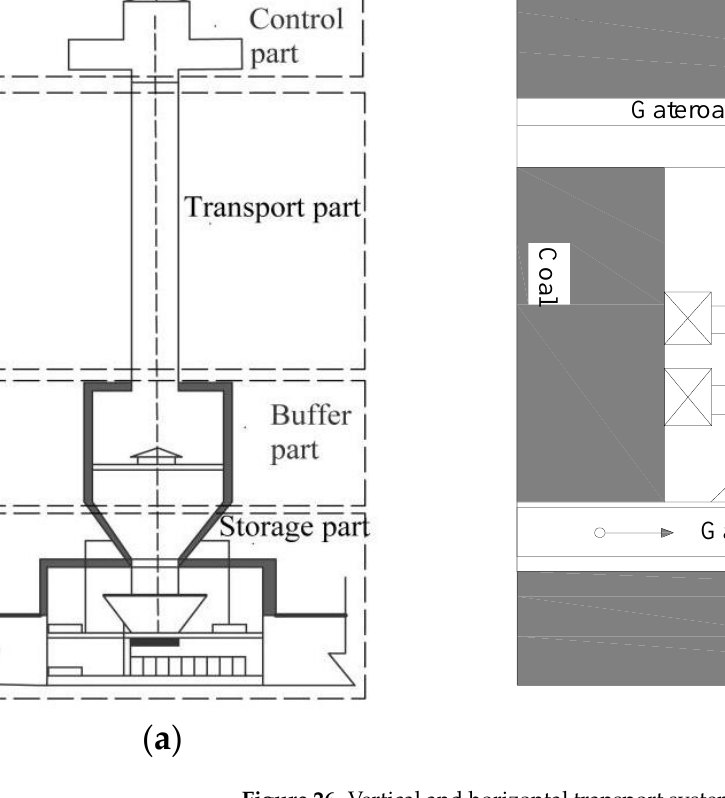
Figure 26. Vertical and horizontal transport systems for gangue filling materials: ( a ) vertical dumping system of gangue; ( b ) gangue conveyer.